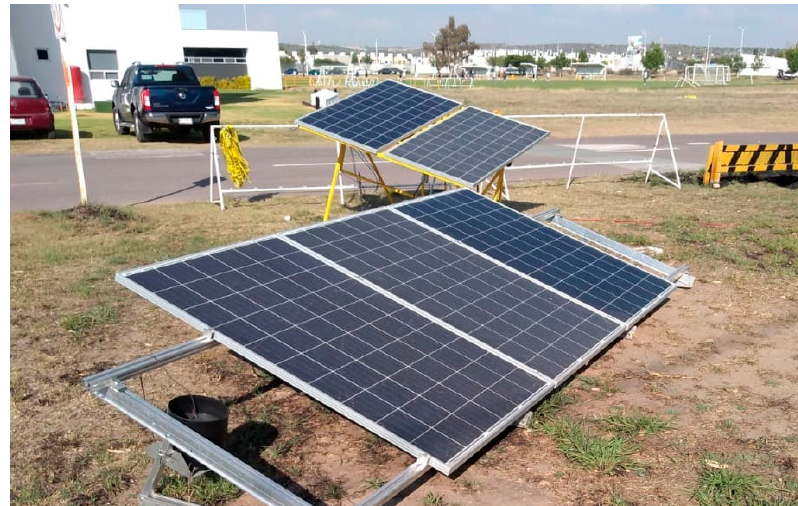
Figure 13. Photo of the fixed and tracking systems.